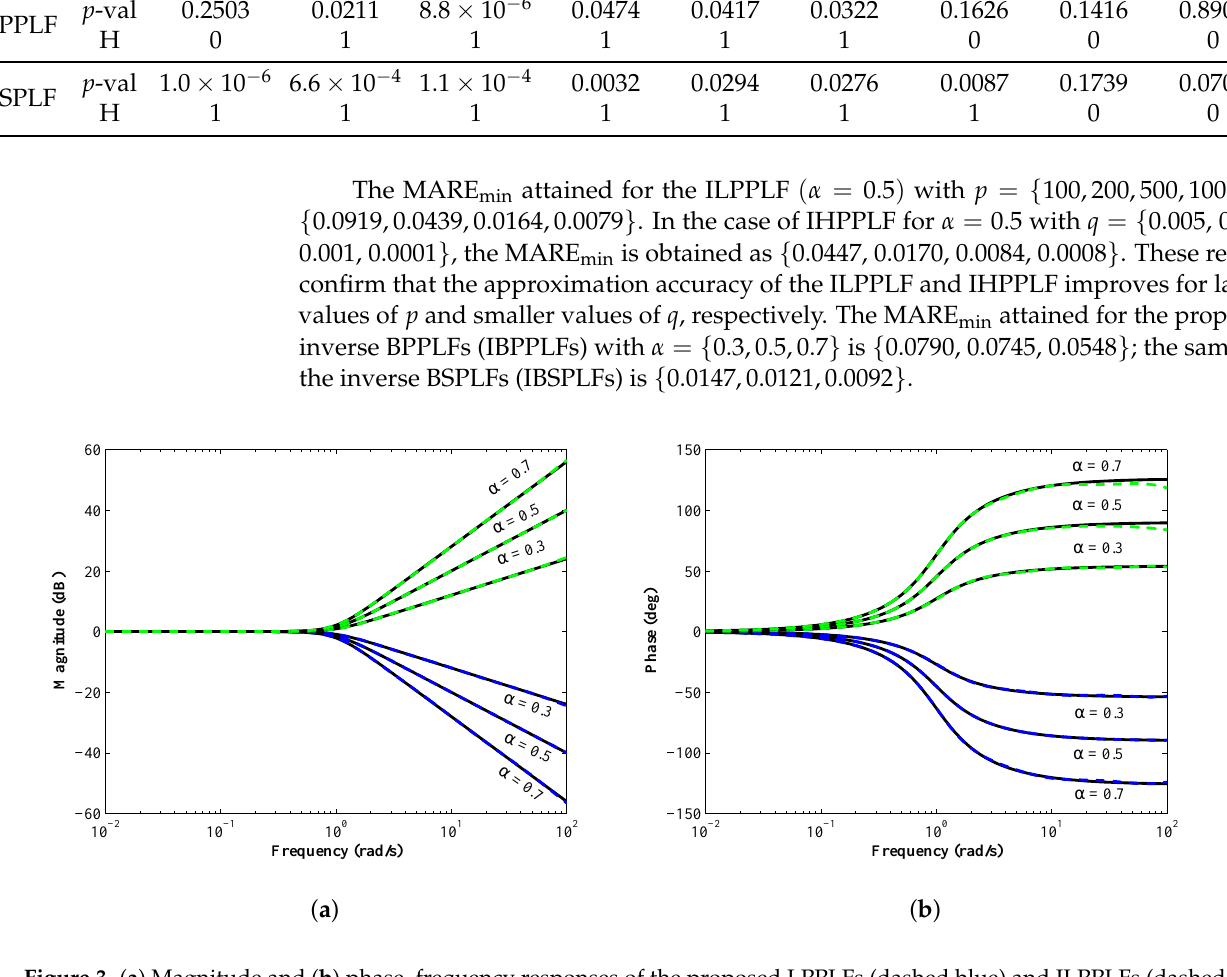
Figure 3. ( a ) Magnitude and ( b ) phase–frequency responses of the proposed LPPLFs (dashed blue) and ILPPLFs (dashed green) as compared to the theoretical ones (solid